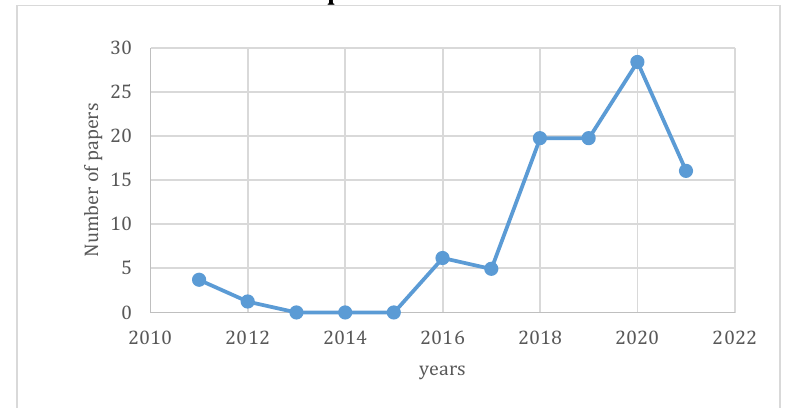
Figure 2: Distribution of the documents among the time span according to their year of publication